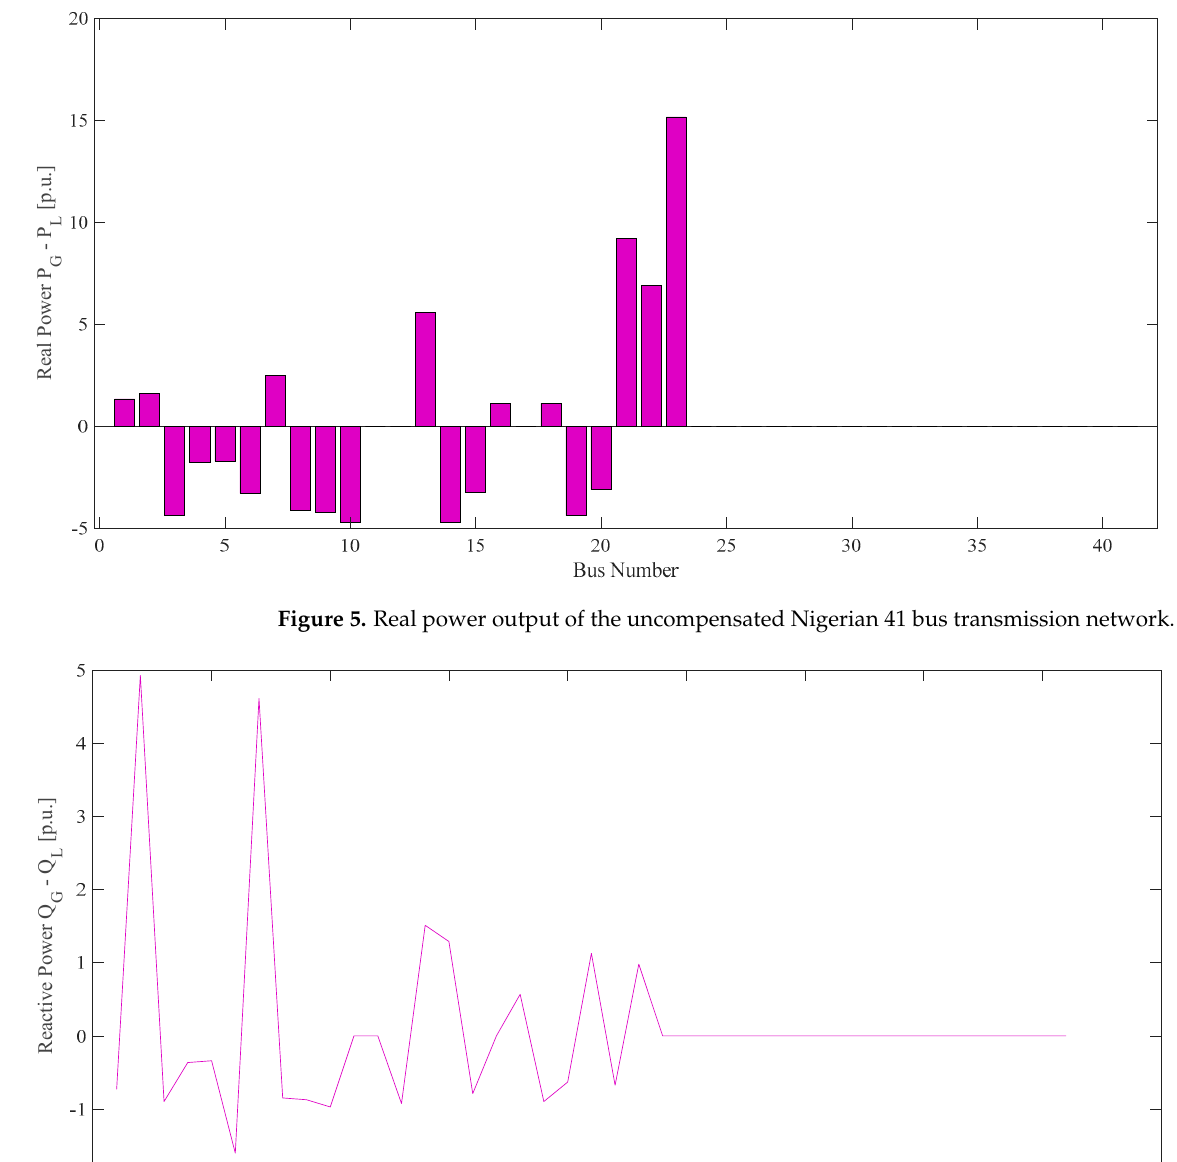
Figure 4. Voltage profile of the uncompensated Nigerian 41 bus transmission network.